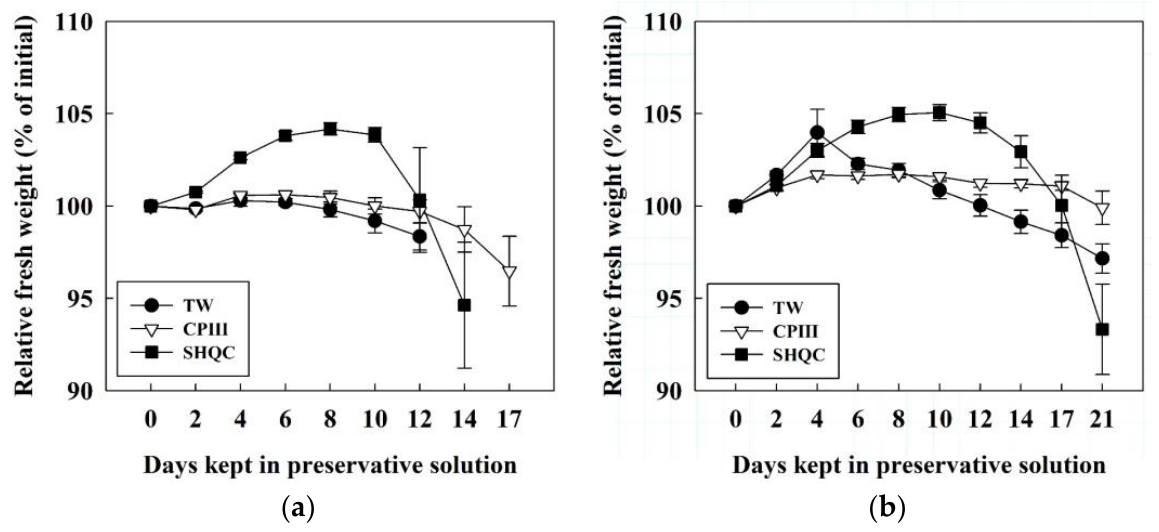
Figure 2. Changes in the relative fresh weight of cut hydrangea flowers ‘Verena’ kept in each preservative solution treatment in ( a ) 2019 and ( b ) 2020. Vertical bars indicate standard deviation of means ( n = 9). TW, tap water; CPIII, 1% Chrysal Professional III; and SHQC, 2% sucrose + 250 mg/L 8-hydroxquinoline + 100 mg/L citric